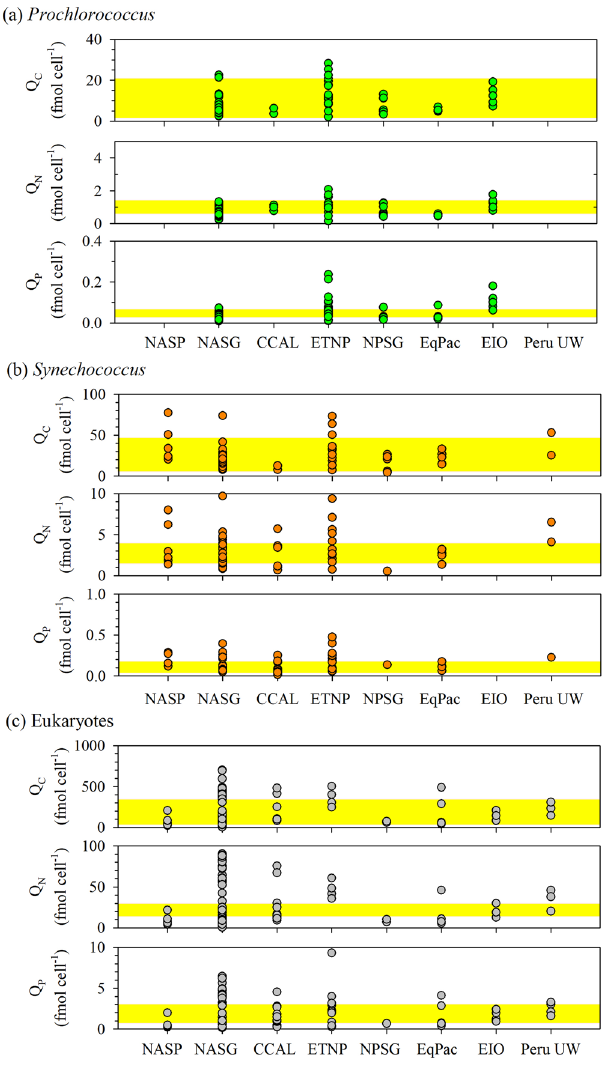
Fig. 2 Biogeographical distribution of phytoplankton carbon, nitrogen, and phosphorus contents. ( a ) Prochlorococcus , ( b ) Synechococcus , and ( c ) eukaryotes, and in each, the upper fi gure is the cellular elemental quota of carbon (Q C ), the middle fi gure is the cellular elemental quote of nitrogen (Q N ) and the lower fi gure is the cellular elemental quota of phosphorus (Q P ). Regions denoted on the x axis are as de fi ned in Fig. 1. For Prochlorococcus , there are no data for NASP and Peru UW as populations were either not present, or in too low an abundance to reasonably achieve a sample for analysis. The yellow shaded regions in each panel represent previously published cell content ranges: C - Casey et al. 20 ; N – Bertilsson et al. 9 for Prochlorococcus and Synechococcus , and Ho et al. 26 for picoeukaryotes; P – Bertilsson et al. 9 for Prochlorococcus and Synechococcus , and Ho et al. 26 and Whitney and Lomas 27,28 for picoeukaryotes.